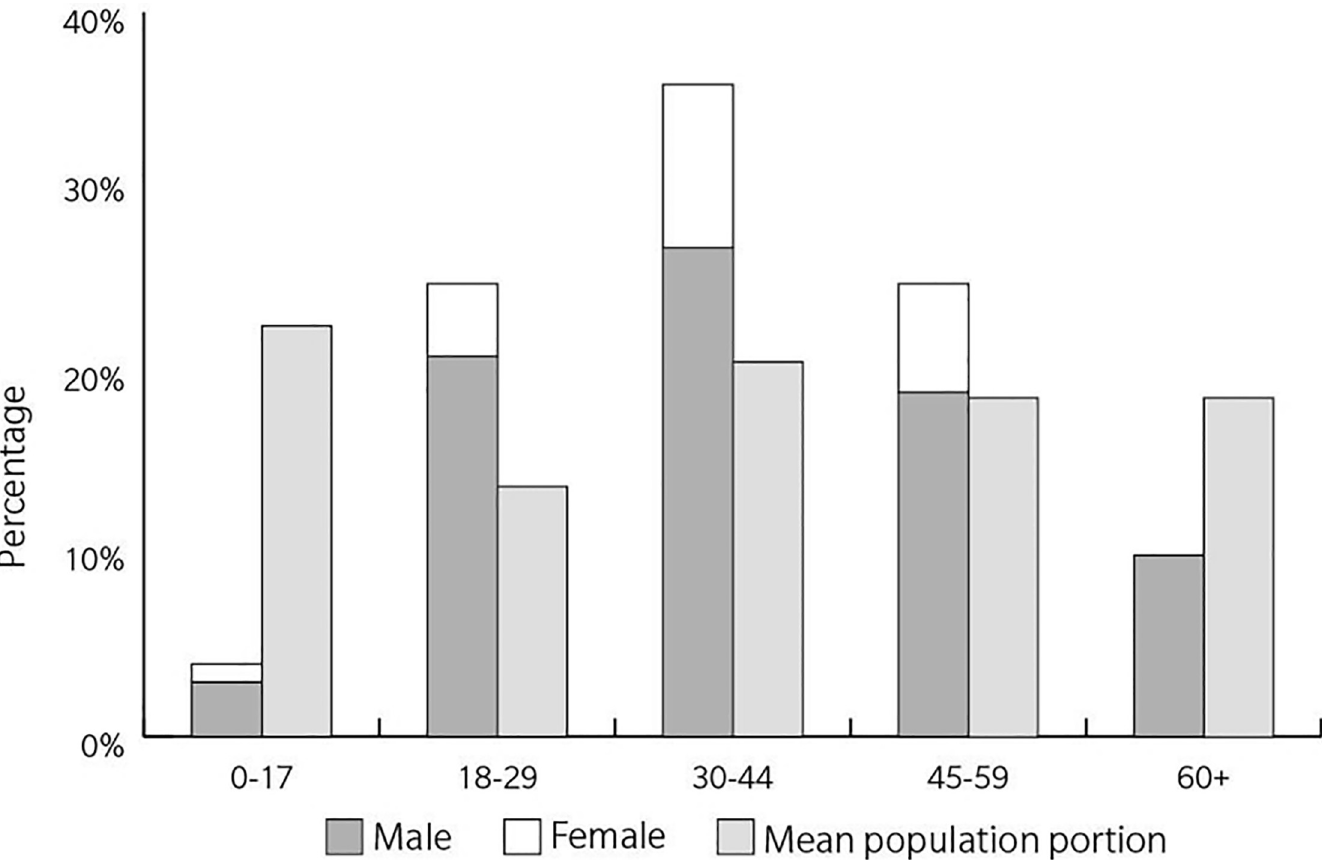
Fig 2. Bystander rescue victim age proportions by gender and compared to mean Australian population proportions (2004–19).